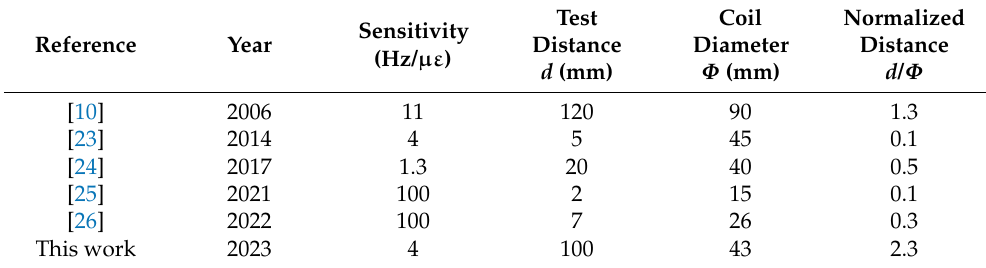
Table 4. The comparison between this work and previous work.